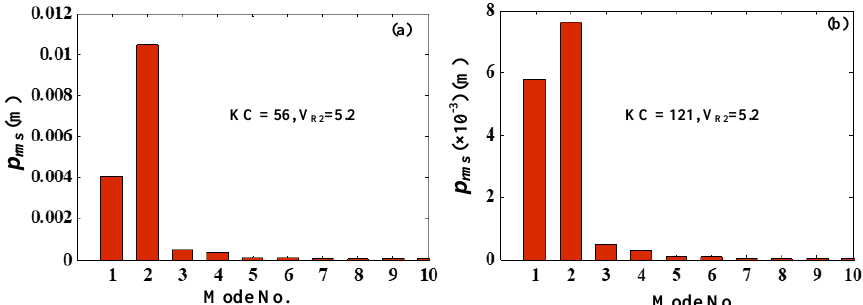
Figure 3. Root mean square values of the displacement modal weights in the cross flow (CF) direction for different KC numbers under V R2 = 5.2.